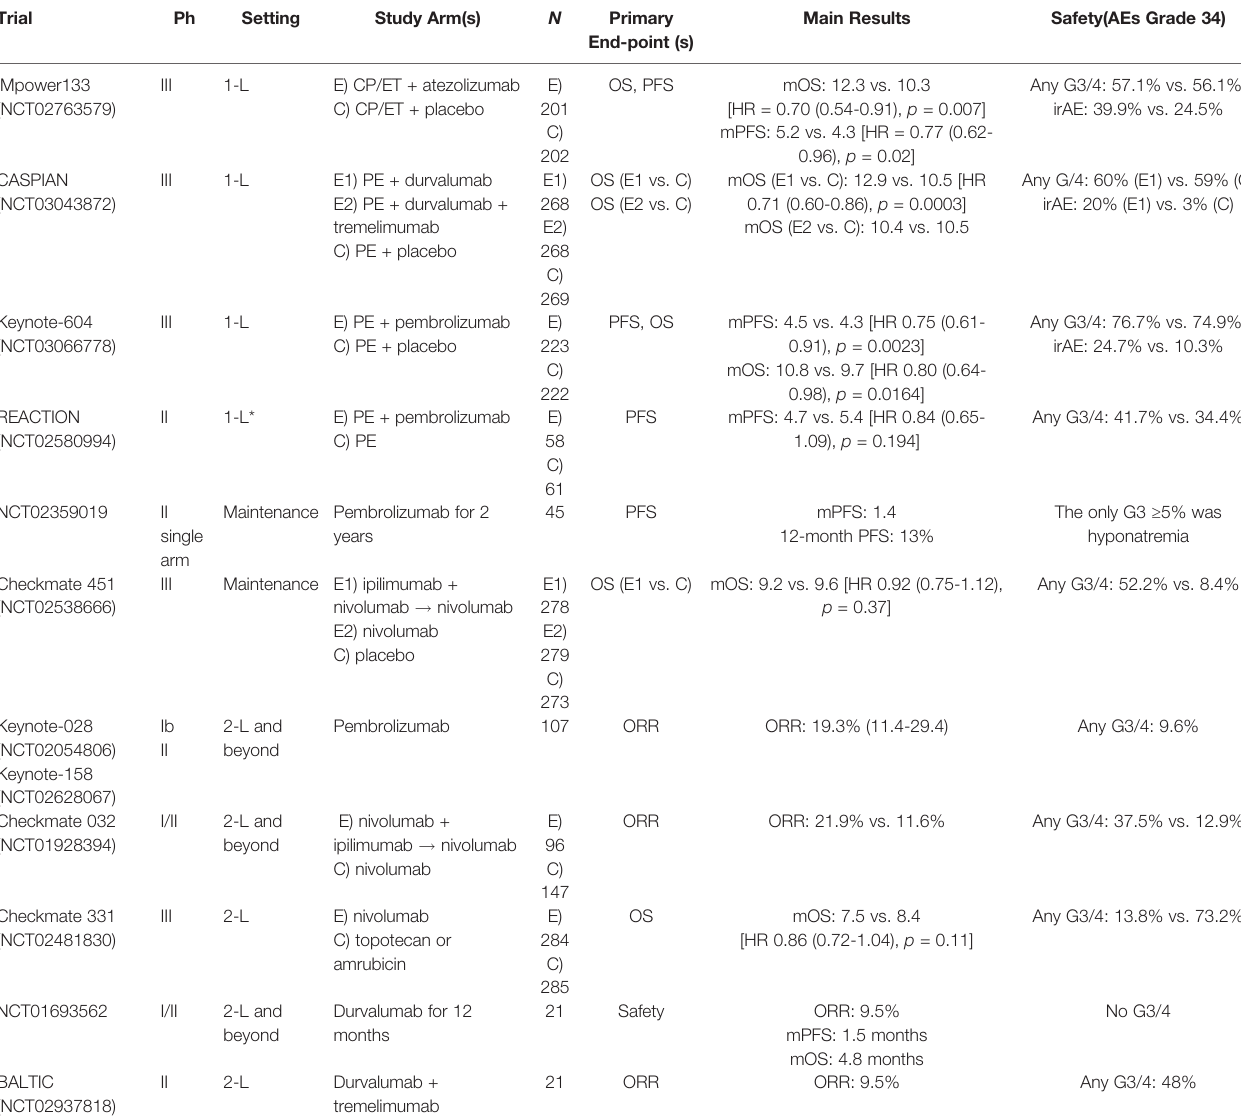
TABLE 2 | Selected randomized clinical trial testing immunotherapy in SCLC extended